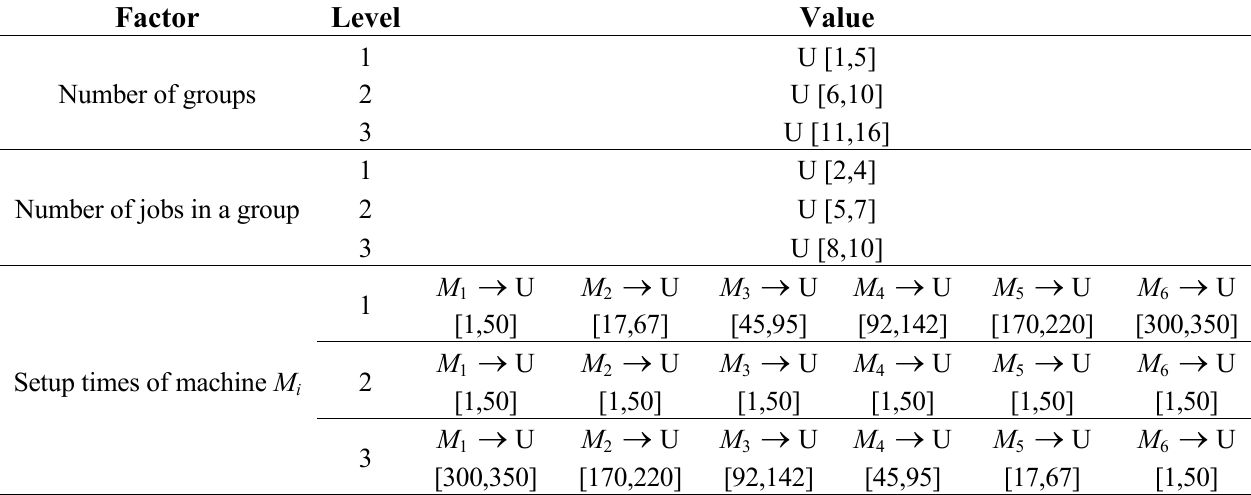
Table 5. Sub-benchmark of instances for the 6-machine FDSGS